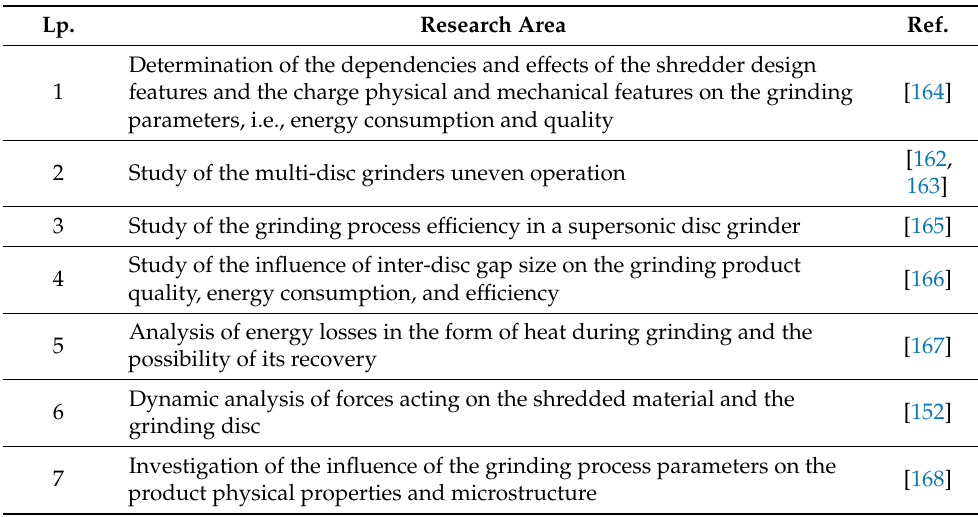
[164] [162, 163] [166] [167]